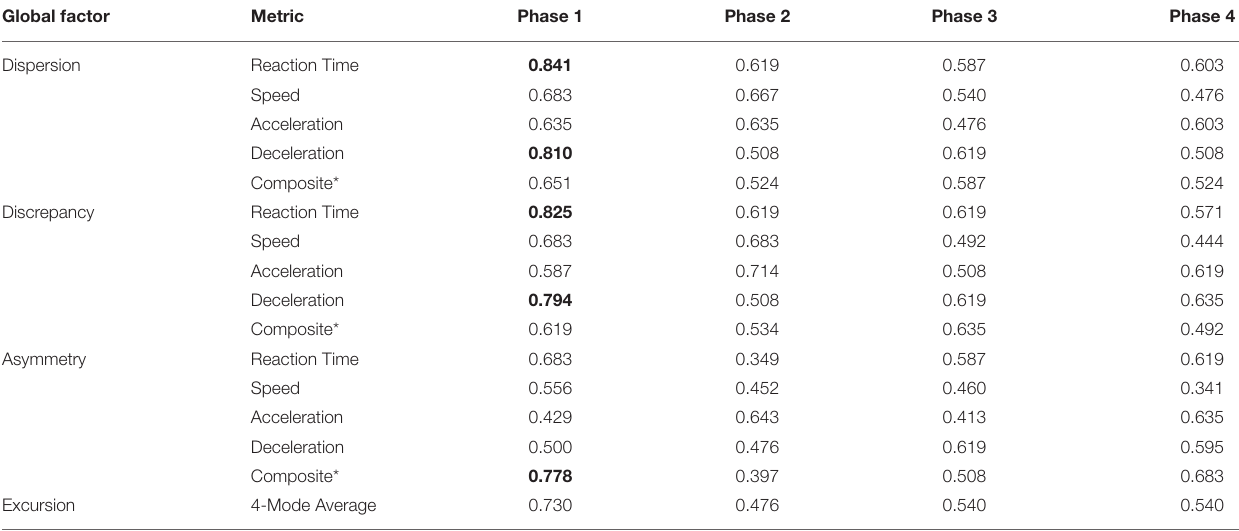
TABLE 9 | Receiver operating characteristic area under curve values for intra-individual variability measures (Dispersion and Discrepancy of t-scores for 2 movement directions and 4 task modes), Asymmetry (differences between movement directions averaged for task modes), and Excursion (distances averaged for task modes). Global